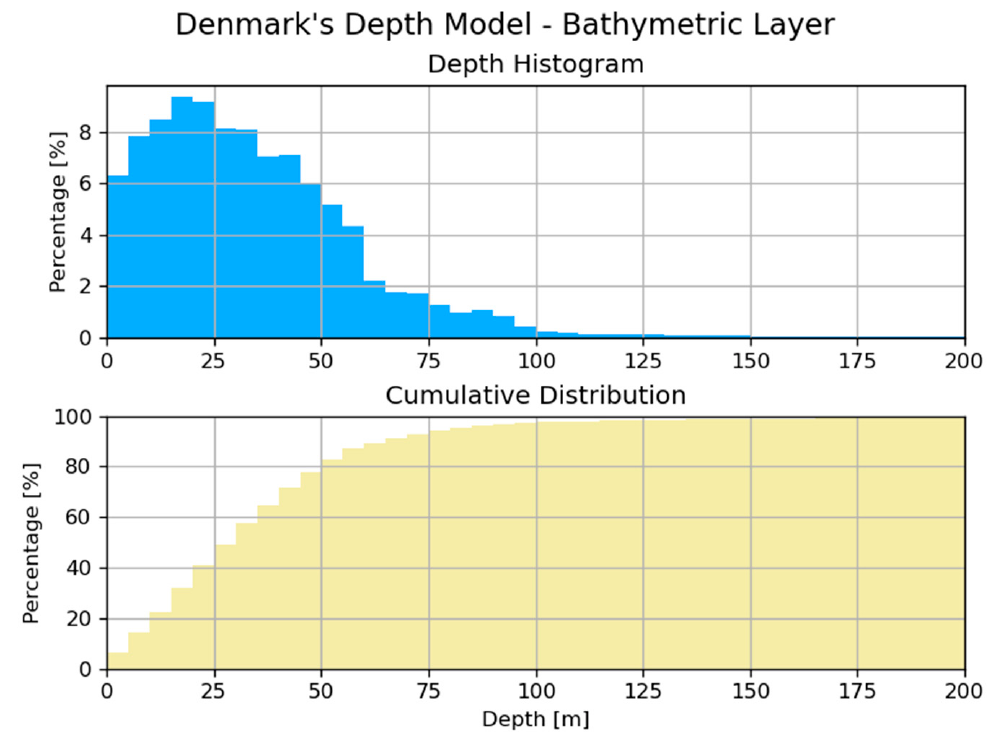
Figure 5. Depth histogram (upper pane) and related cumulative distribution (lower pane) for Den- mark’s Depth Model’s bathymetric layer. For better visualization, an upper limit of 200 m has been applied to the axis of the depth values.